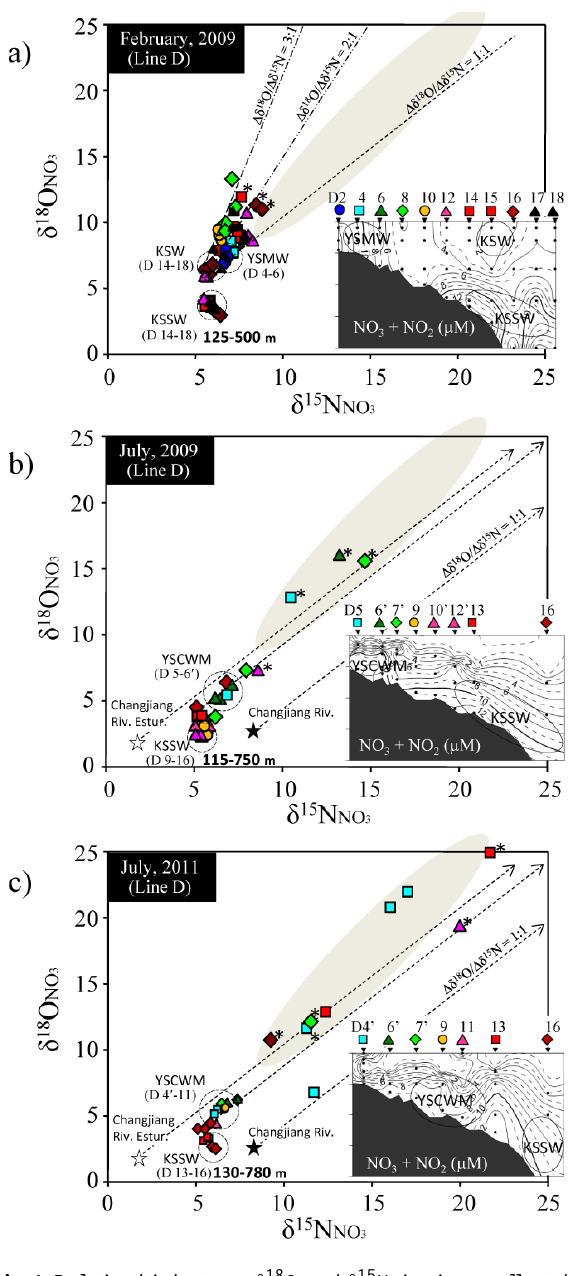
Fig. 4. Relationship between δ 18 O and δ 15 N in nitrate collected at each location along transect D in (a) February 2009, (b) July 2009, and (c) July 2011. The symbols with asterisk ( ∗ ) are the samples col- lected at the layer of chlorophyll maximum. The dotted line and the two-dot chain line indicate the lines of 1δ 18 O: 1δ 15 N=1:1 and 2:1, respectively. The closed and open stars indicate δ 15 N and δ 18 O values in the lower stream of the Changjiang River and Changjiang River Estuary, reported by Li et al. (2010) and Chen et al. (2013), respectively. Oval hatch indicates the range of δ 15 N and δ 18 O in NO 3 observed in the Changjiang River Estuary and adjacent west- ern ECS (31–33 ◦ N, 122–126 ◦ E) reported in Chen et al. (2013).